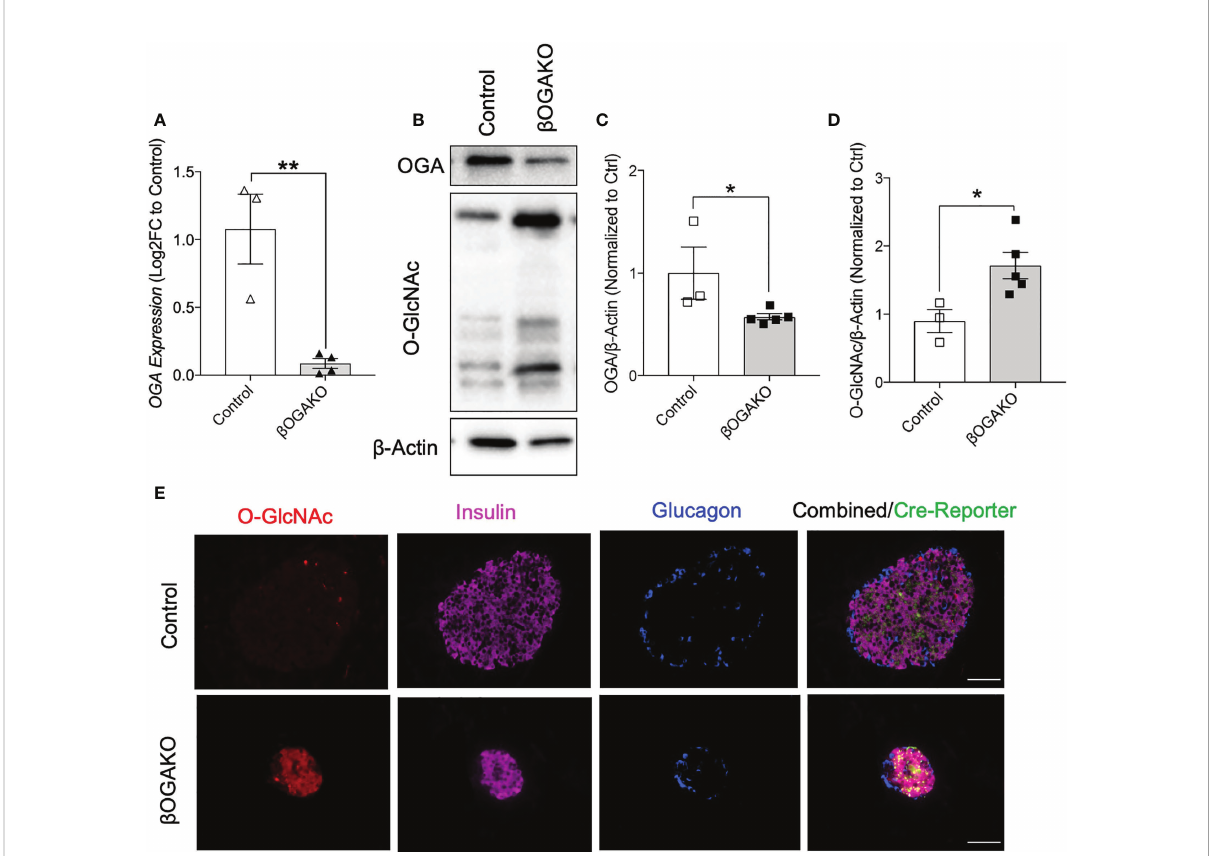
FIGURE 1 Validation of the b -Cell Speci fi c Deletion of OGA. OGA mRNA level from pancreatic islets of control and b OGAKO mice (A) , normalized to beta- Actin mRNA (n=3-4). Representative western blot (B) and quanti fi cation of OGA (C) and pan O-GlcNAcylation (D) , normalized to beta-Actin (n=3-5). Immuno fl uorescence image of pancreatic islets showing O-GlcNAcylation (Red), Insulin (Purple), Glucagon (Blue) and Cre Reporter (Green) in Control and b OGAKO pancreas (E) . 40x magni fi cation. Scale bar = 50 m m. Statistical analyses were conducted using unpaired, 2-way student t-test with signi fi cance *p<0.05,